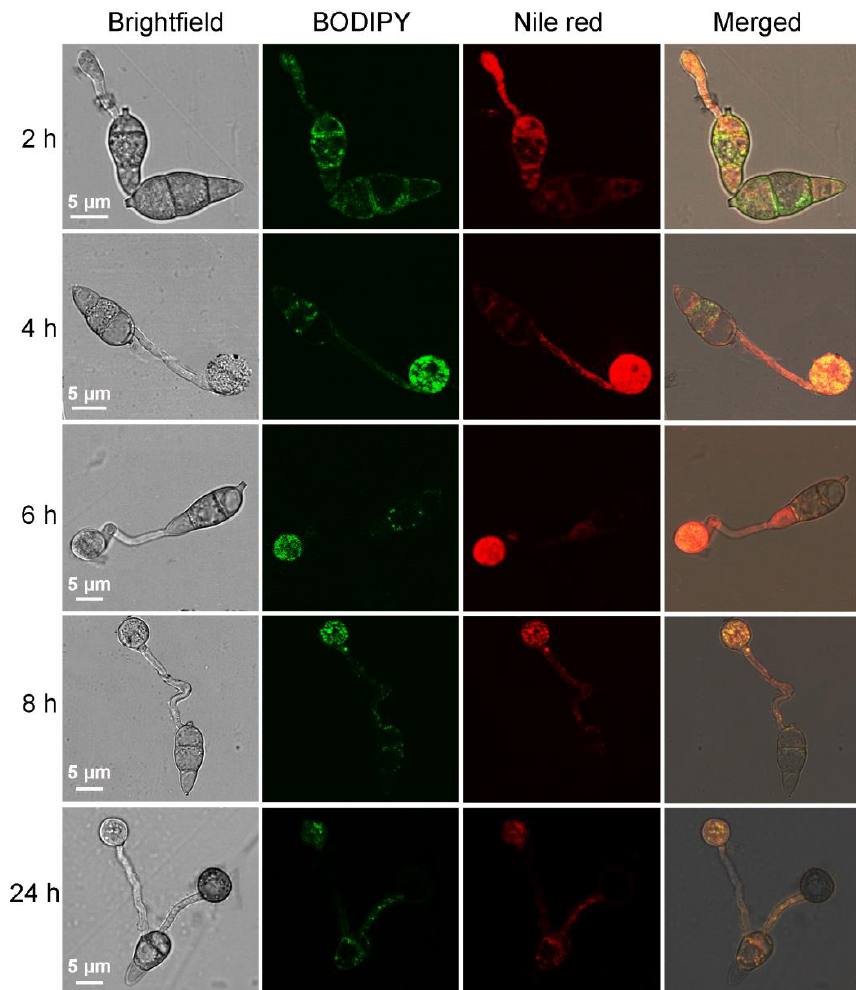
Figure 2. Tracing the migration of lipids in Magnaporthe oryzae strain Guy11 during conidium germination and appressorium formation with BODIPY and Nile red.